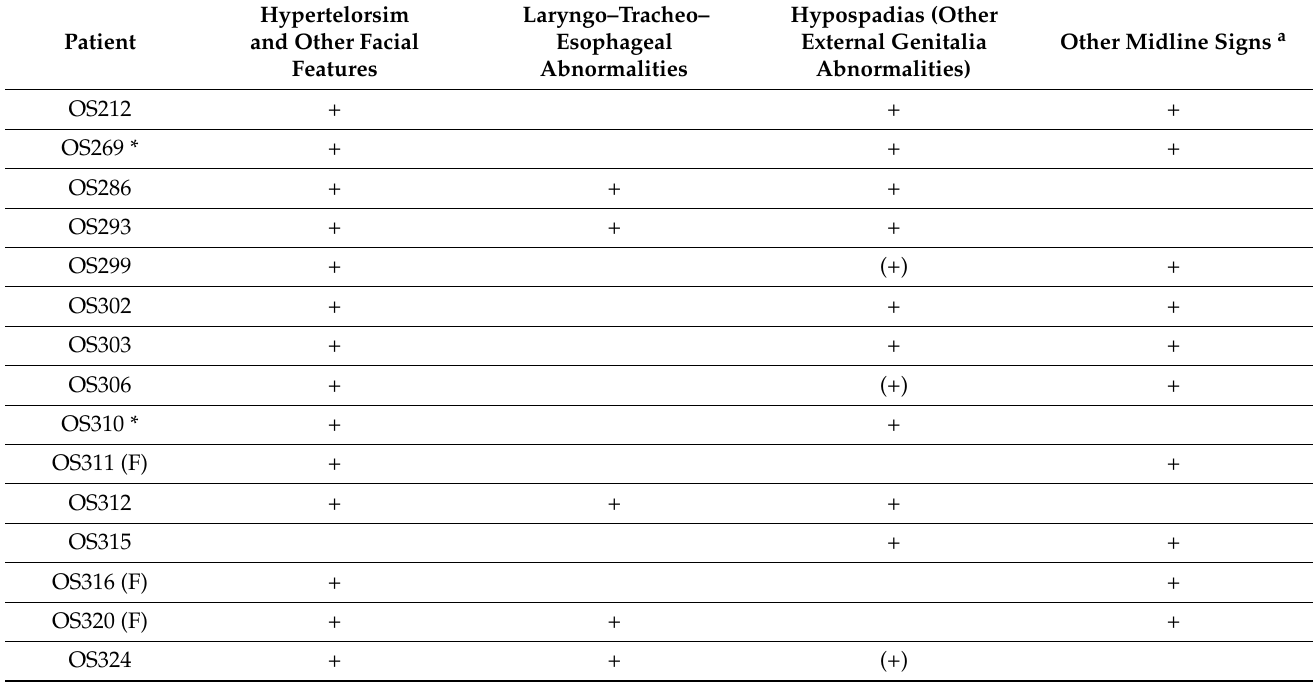
Table 1. Main clinical signs of this study